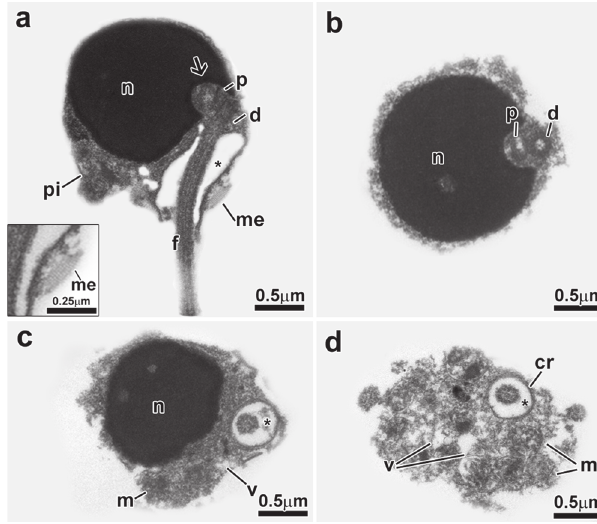
Fig. 7. Spermatozoon of Micralestes acutidens . a, a-inset: longitudinal sections. b, c, d: transverse sections from top to posterior region. The nucleus (n) is spherical and lies strongly eccentric to the flagellum (f). The centriolar complex (p, d) and nuclear fossa (arrow) is strongly eccentric. The proximal centriole (p) is lateral and perpendicular relative to the distal centriole (d). The cytoplasmic canal is present (asterisk). The midpiece (pi) is strongly asymmetrical, and contains the spherical mitochondria (m) and vesicles (v). The membrane of the midpiece (me) has a striated aspect along its length (a, a- inset). Legends: cr: concentric membranous rings, d: distal centriole, f: flagellum, m: mitochondria, me: membrane of the midpiece, n: nucleus, p: proximal centriole, v: vesicle, asterisk: cytoplasmic canal, arrow: nuclear